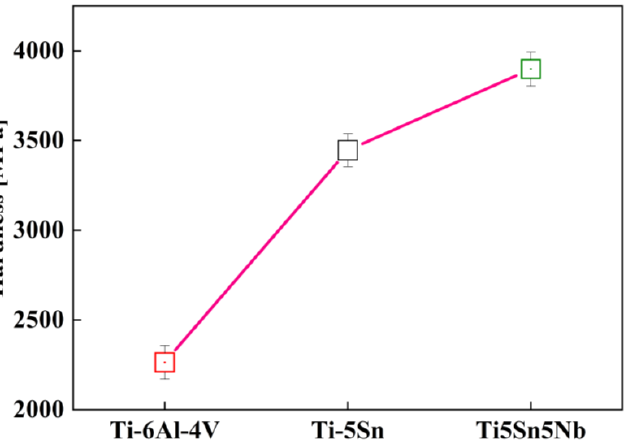
Figure 8. Nanoindentation hardness versus Ti-based alloy composition at 50 Mn load with dwell time of 3 s, the red curve depicts the harness of tested samples.